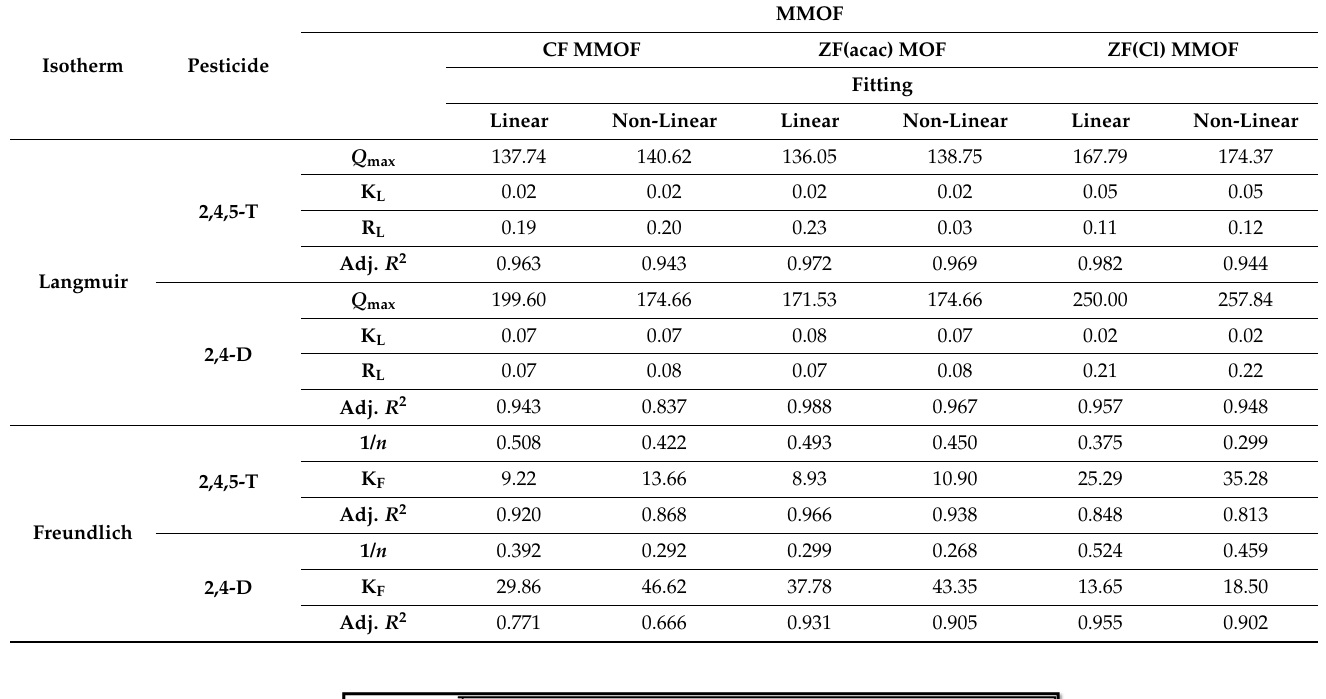
Table 2. Adsorption data for all three MMOFs, both tested pesticides, fitted to Langmuir and Freundlich models, both linearly and non-linearly.